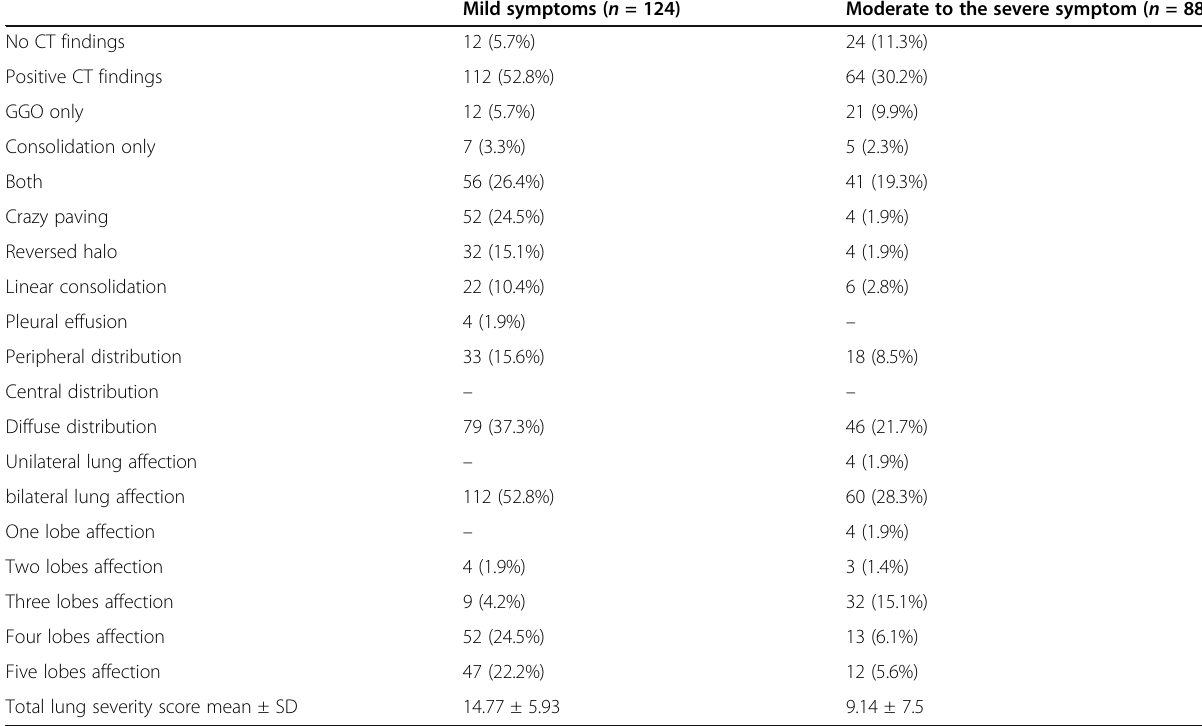
Table 3 Distribution and frequency of the CT pulmonary abnormalities according to the severity of symptoms Mild symptoms ( n =